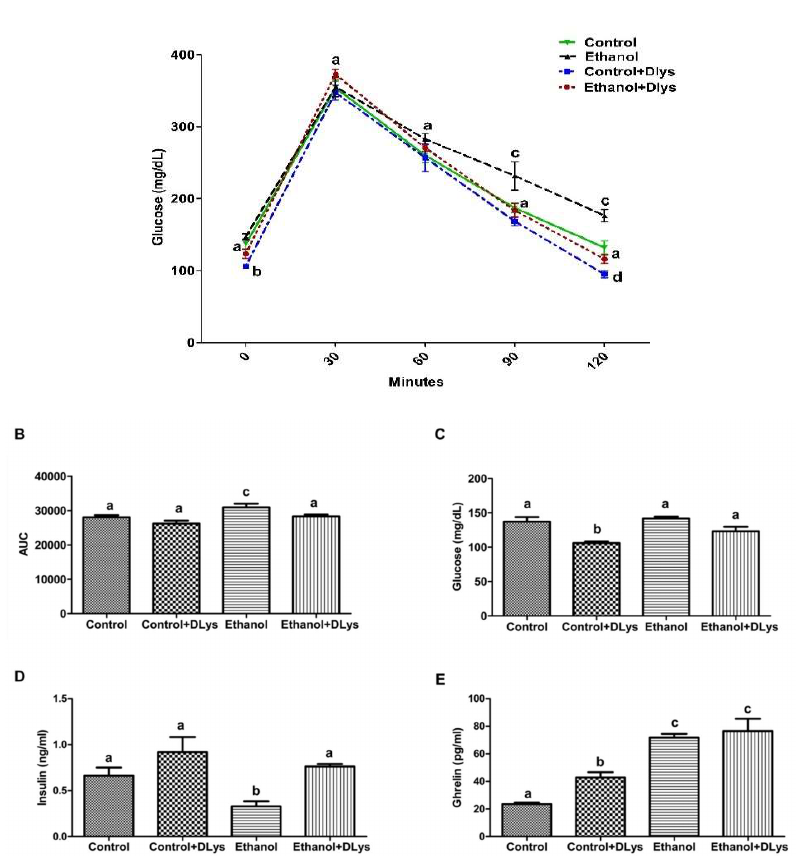
Figure 1. Inhibition of ghrelin activity inhibits the chronic alcohol-induced impaired glucose tolerance and altered serum fasting insulin levels in the rats. ( A ) Glucose tolerance tests (GTT) were performed, as described under experimental procedures. ( B ) Area under the curve (AUC) from GTT. ( C ) Serum glucose. ( D ) Serum insulin. ( E ) Serum ghrelin levels after 6 h fasting. Values are means ± SEM (n = 8– 10). Values not sharing a common letter are statistically different, p ≤ 0.05.